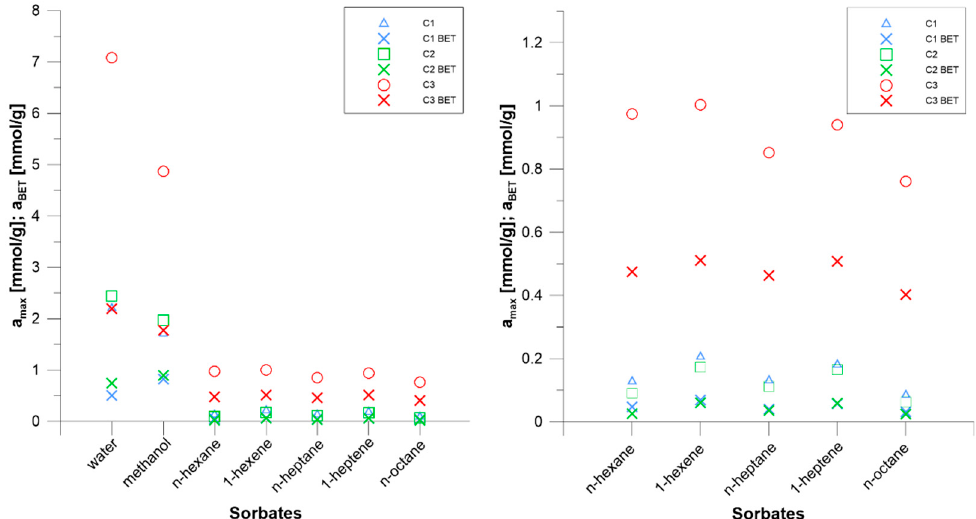
Figure 6. Maximum values of sorption (Ci max) and BET monolayer adsorbed quantities (Ci BET) of water vapour, methanol vapour, n-hexane, 1-hexene, n-heptane, 1-heptene, and n-octane on coals C1, C2, C3.